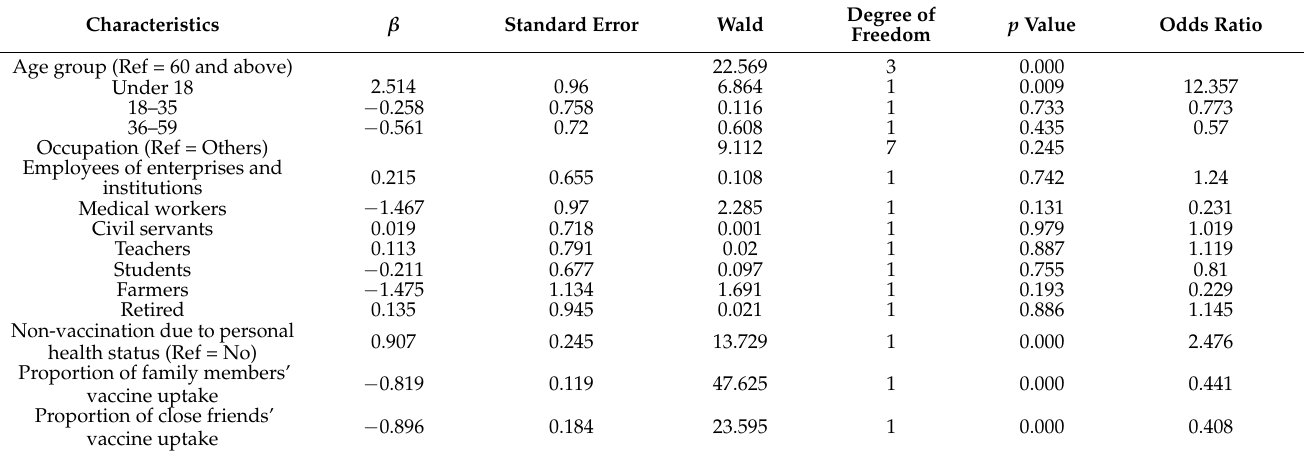
Table 5. Results of binary logistic